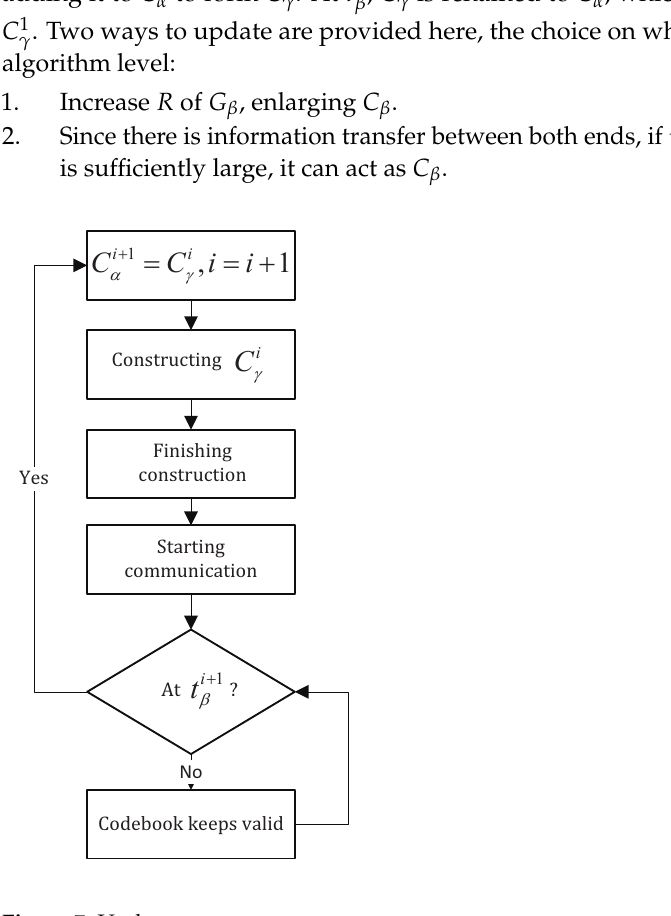
Figure 7. Update